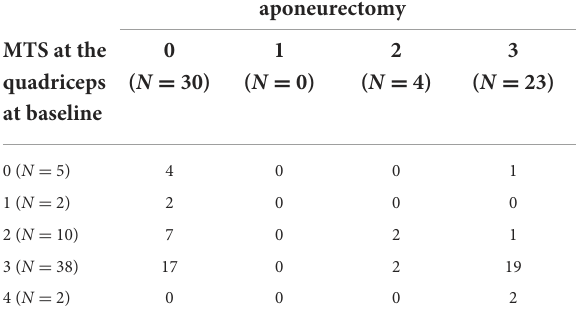
TABLE 2 Two-way table of MTS scores in the CASE group ( N = 57) at baseline and 1 month after surgery inclusive of QF aponeurectomy.